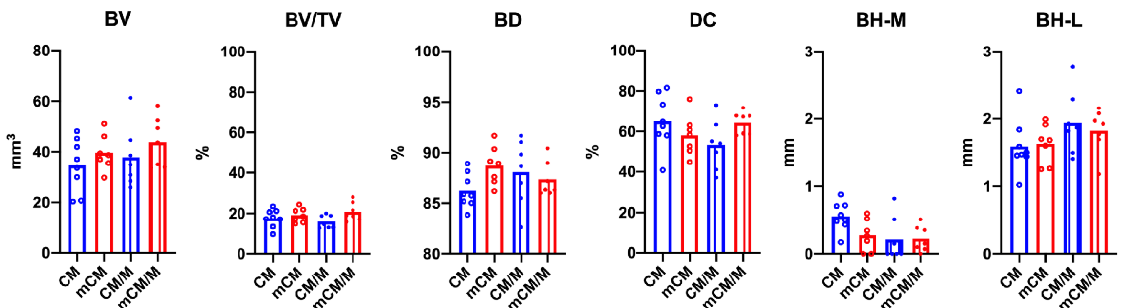
Figure 5. The results of micro-CT morphometry at 12 weeks post-surgery. Any of the groups did not show statistically significant differences, but mCM/M group showed greater bone formation from the defect boarders when compared to mCM alone